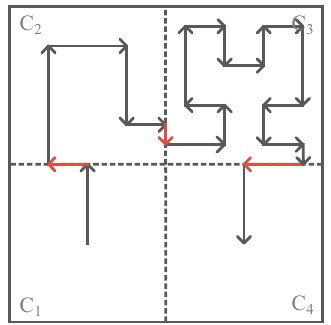
Figure 6. The traversing trajectory design on border (the red line).